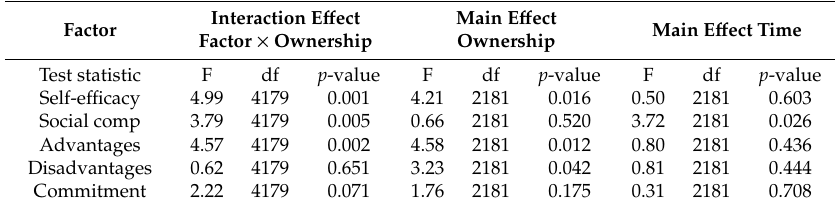
Table 2. General Linear model of the changes in social cognitive factors over time (T0, T1, and T2). Factor